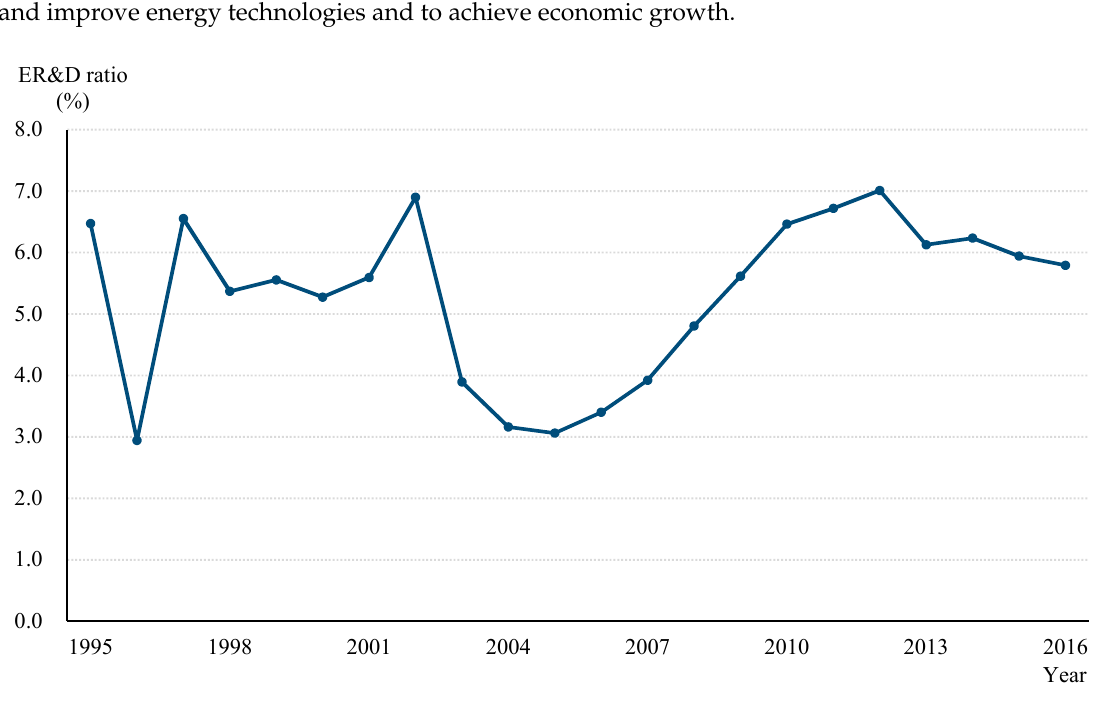
Figure 2. The ratio of ER&D investment to total R&D investment in South Korea [36].